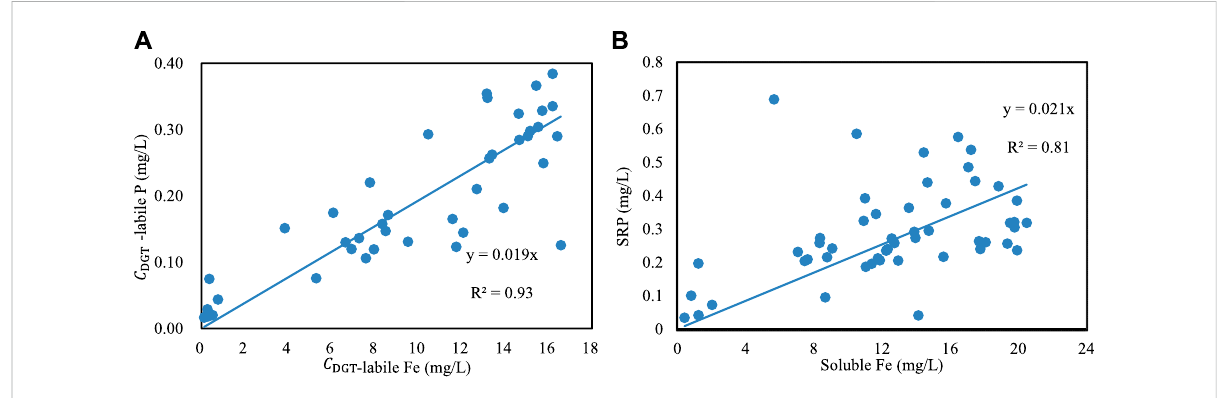
FIGURE 2 Relationships between P and Fe concentrations. (A) DGT-labile P and DGT-labile Fe, and (B) SRP and soluble Fe.